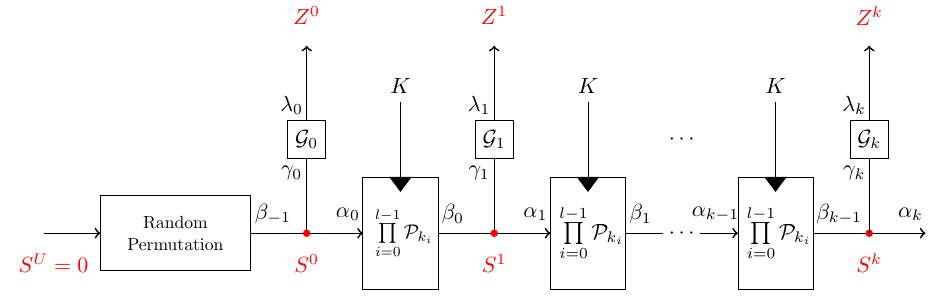
Figure 5: Linear masks for a general key stream